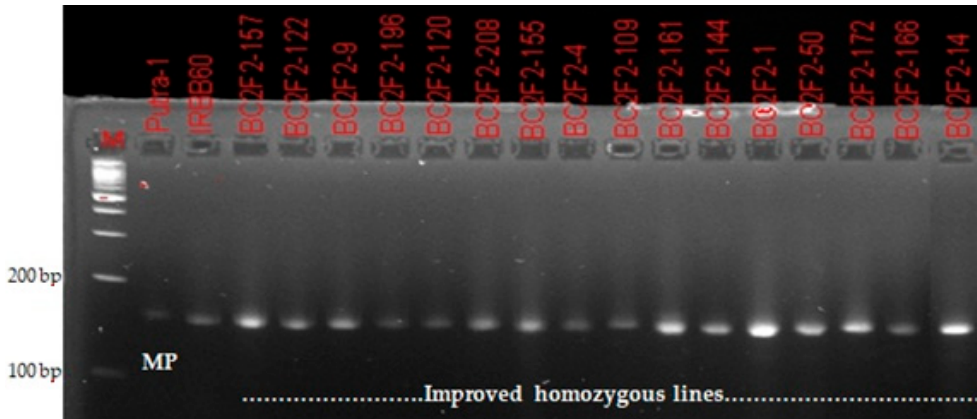
Figure 2. Confirmation of bacterial leaf blight resistance in homozygous improved lines using the functional marker MP.